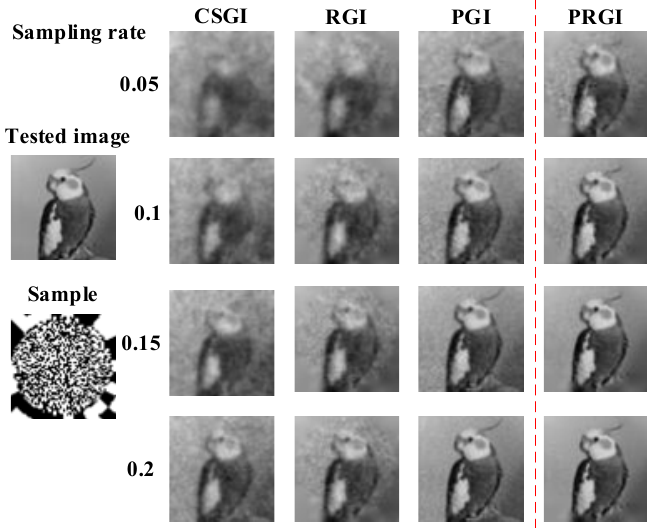
Figure 3. Reconstructed results of ‘CSGI’, ‘PGI’, ‘RGI’, and ‘PRGI’ under different sampling rates.